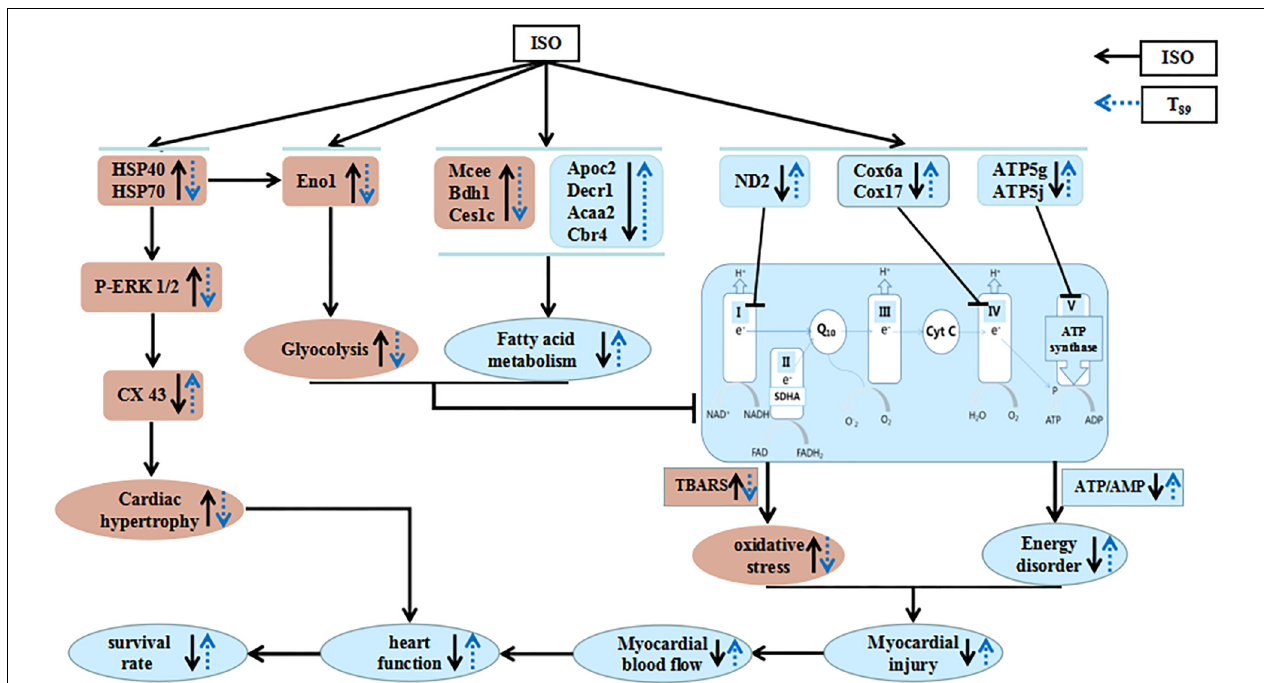
FIGURE 8 | A diagrammatic sketch showing the pathways that lead to the protected effects of T 89 on ISO-induced cardiac injury. ISO causes enhancement of glycolysis and reduction of fatty acid metabolism and oxidative phosphorylation, resulting in energy disorder and oxidative stress with myocardial injury and reduction of MBF. Meanwhile, ISO-educed cardiac hypertrophy via regulating HSP70-ERK1/2 signals, which, together with cardiac injury, finally caused reduction of heart function and low survival rate. Nevertheless, T 89 administration reversed all the above alteration. The cardioprotective role of T 89 depended on the regulation of glycolipid metabolism, recovery of mitochondrial function, and improvement of myocardial